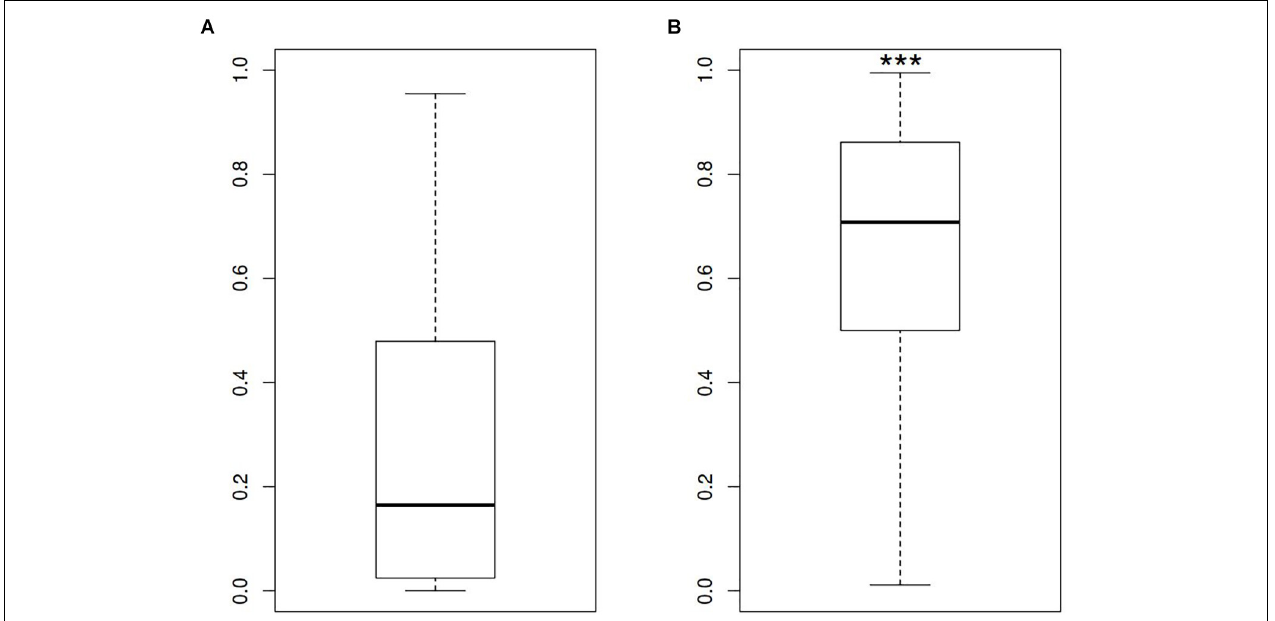
FIGURE 5 | SIDD profile maximum values for (A) vlhA promoters of 12 M. gallisepticum strains and (B) sigma 70 promoters of S6 strain. ∗∗∗ Mann–Whitney test p -value <